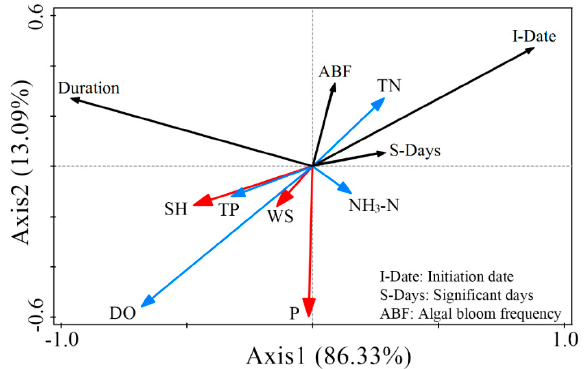
Figure 18. Redundancy analysis (RDA) ordination diagram of interannual algal blooms in Lake Dianchi during 2000–2018. Black arrows, algal bloom variables; red arrows, meteorological parameters; and blue arrows, water quality parameters.